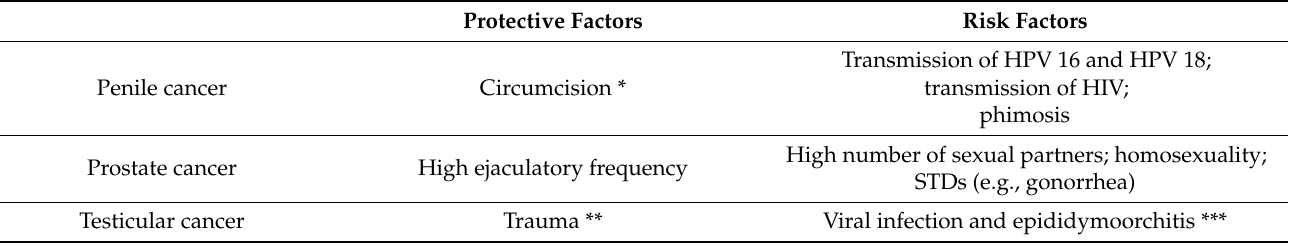
Table 2. Role of SA in development of male genital